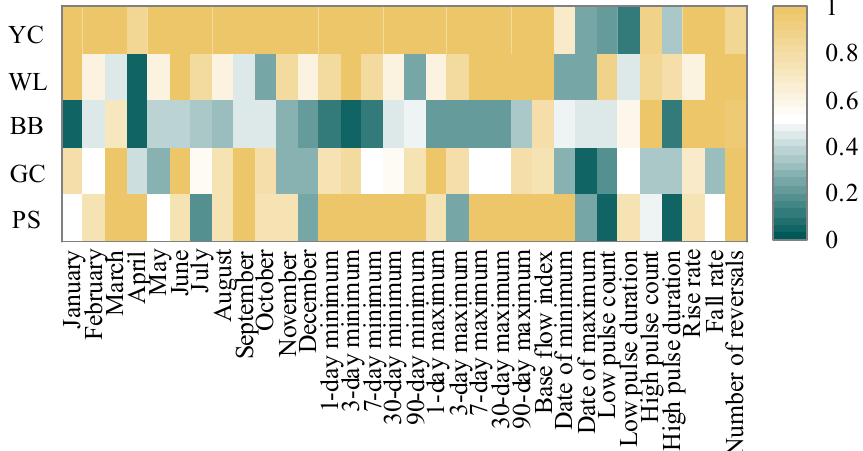
Figure 4. The change degree of each hydrological index at stations in the upper Yangtze River (above is runoff below is sediment).